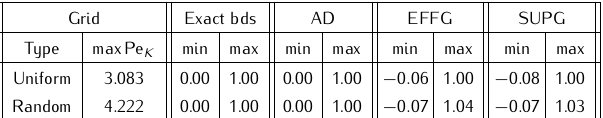
Table 3. Violation of the global solution bounds for the double glazing problem with ε uniform and randomly perturbed